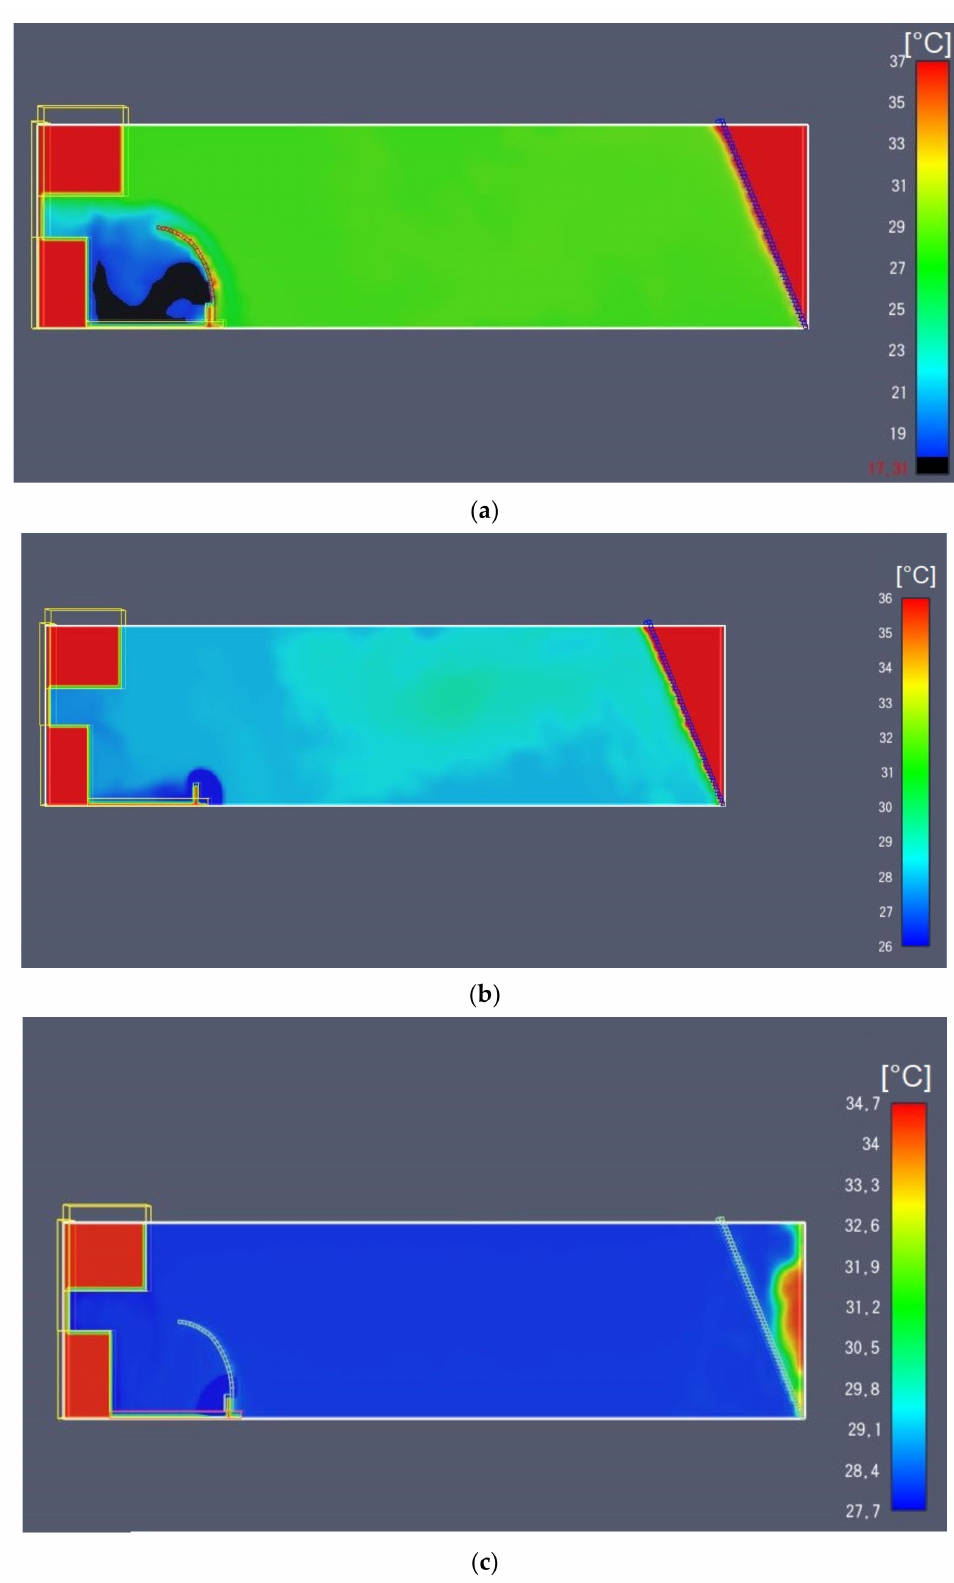
Figure 7. Air temperature distribution [ ◦ C] at time step t = 250 s for: PA configuration ( a ), PB configuration without carter ( b ) and PA_1 ( c